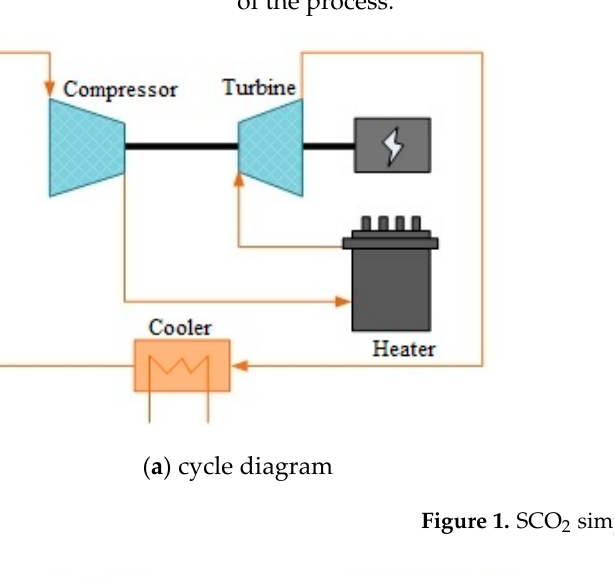
Figure 2. SCO 2 simple recuperated cycle.